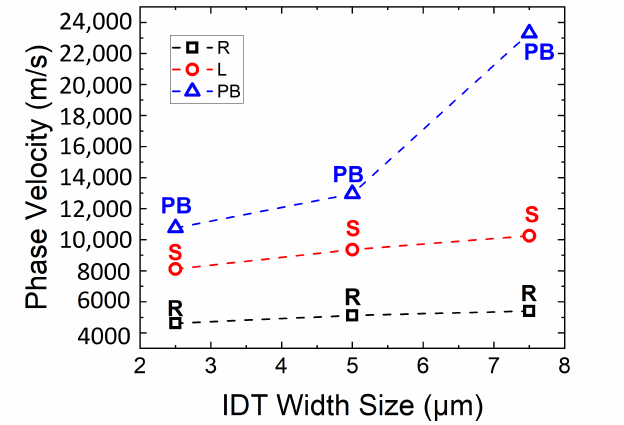
Figure 7. Phase velocity versus IDT width size with the condition of a guiding layer. R is the Rayleigh mode, S is the Sezawa mode, and PB is the pseudo-bulk